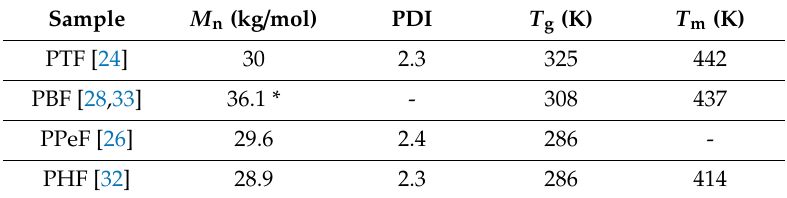
Table 1. Molecular and thermal characterization data of the poly(alkylene 2,5-furanoate) samples studied. Sample M n (kg/mol) PDI T g (K) T m (K) PTF